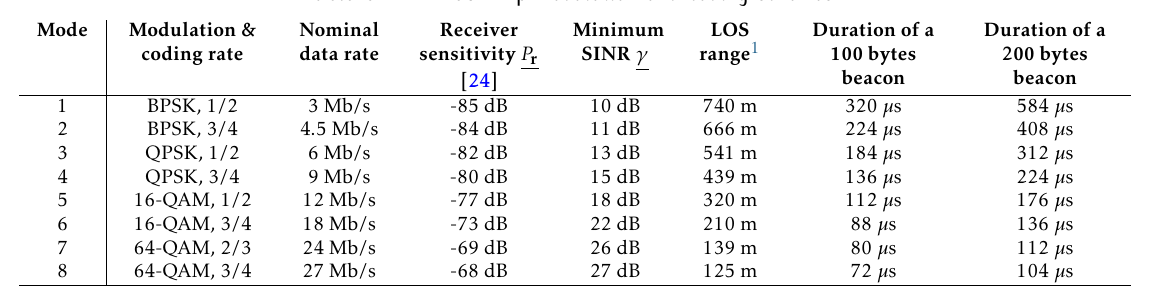
Table 3. IEEE 802.11p modulation and coding schemes.